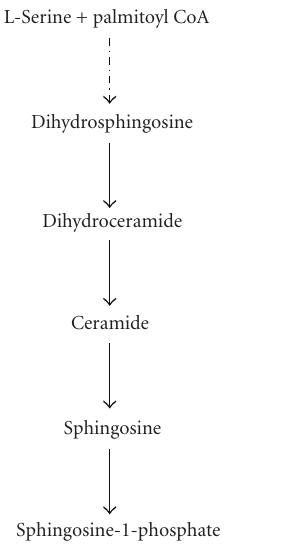
Figure 1: De novo ceramide